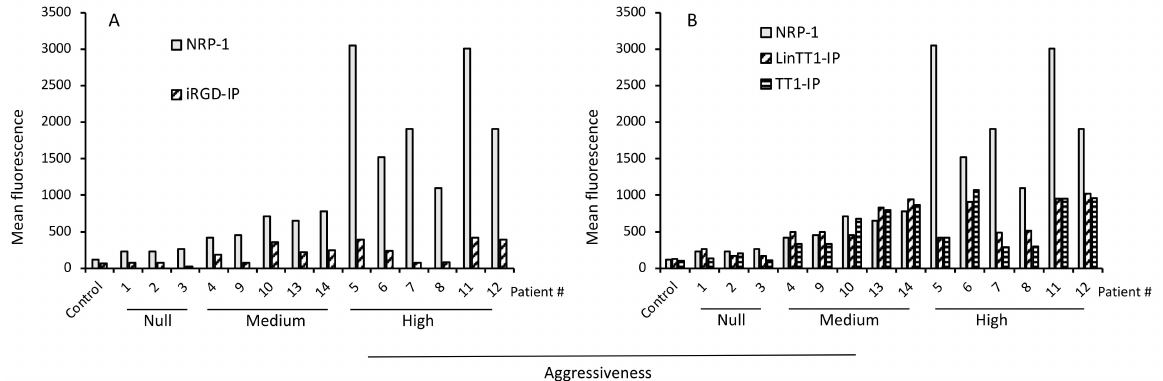
Figure 4. Secondary receptor expression and internalization of TPP-IPs. ( A ) Expression of secondary receptor (NRP-1) and iRGD-IP internalization. ( B ) Expression of secondary receptor (NRP-1) and internalization of LinTT1-IP and TT1-IP. Data are from Figure